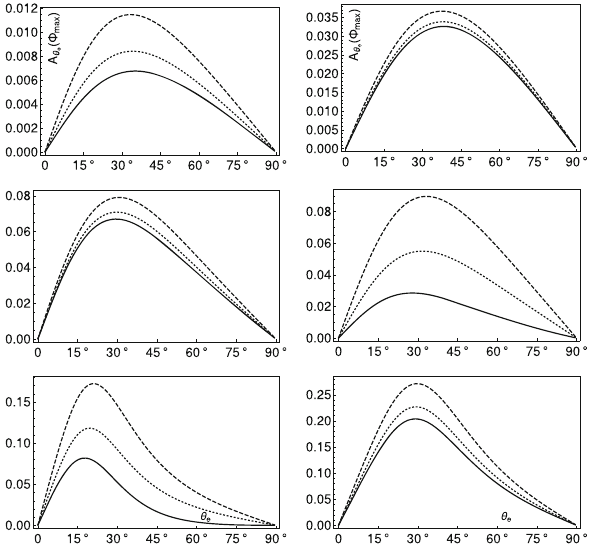
Fig. 5 Superposition of LC ν e s with RC ones in presence of non- (Φ ) asafunction standardcouplingswith ˆ η ν ·ˆ q = − 0 . 95:plotof A θ max e of θ e for the case of V – A with S R when E ν = 1 MeV , φ ν = 0; left column for Dirac ν e , right column for Majorana ν e ; upper plot for θ = 0 . 1; middle plot for θ = π/ 2; lower plot for θ = π − 0 . 1; solid 1 1 1 | = 0 . 3, θ = 0; dotted line for | c R | = 0 . 3, θ = π/ 4; line for | c R S , R S , R S S | = 0 . 3, θ = π/ dashed line for | c R S , R S